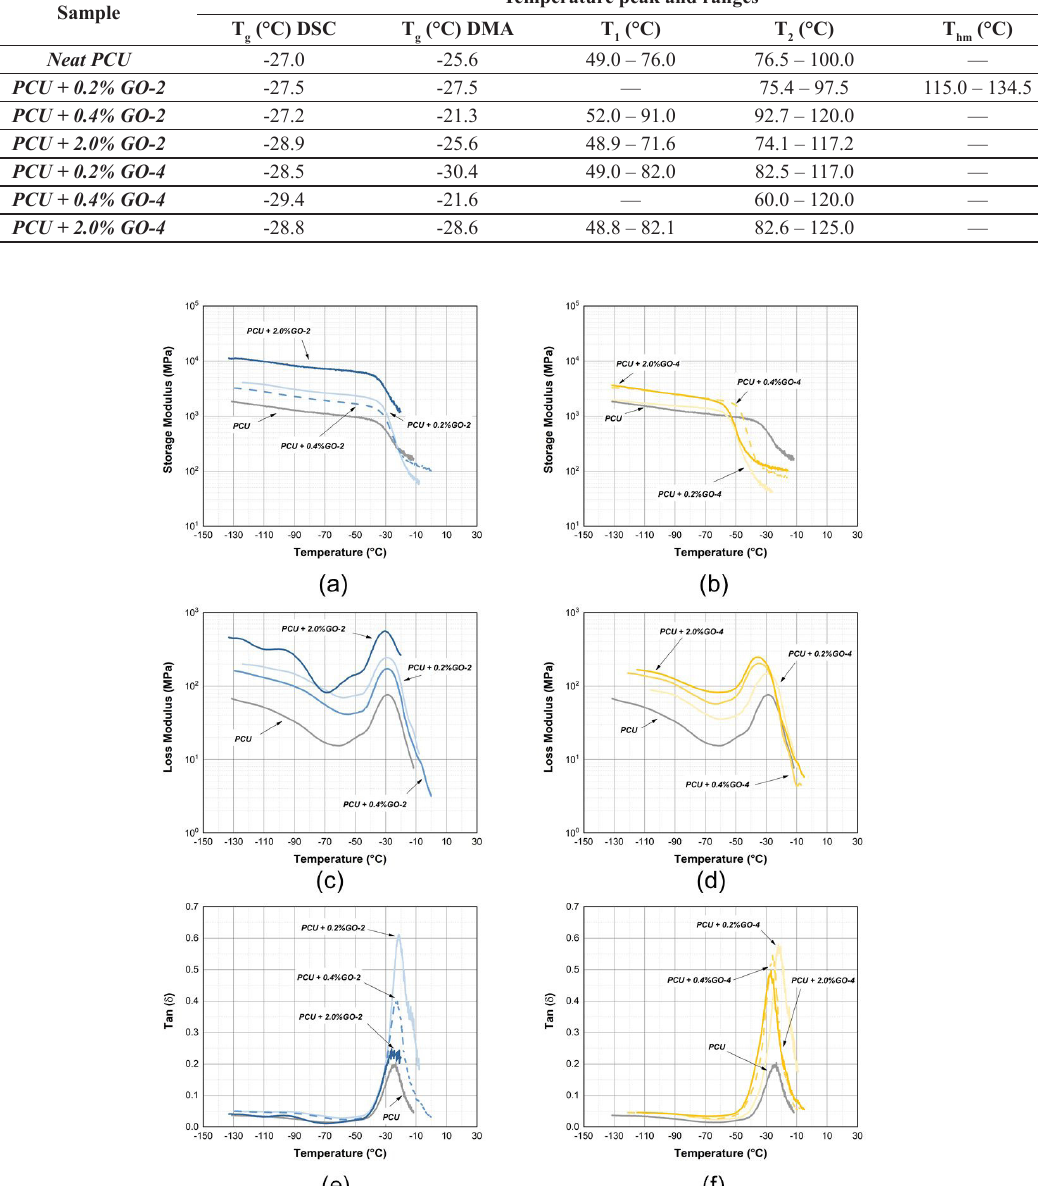
Figure 10. DMTA curves for: storage module - E’ (a) and (b), loss module - E” (c) and (d), energy dissipation factor - Tan δ (e) and (f), as a function of temperature for neat PCU and its nanocomposites with GO-2 and